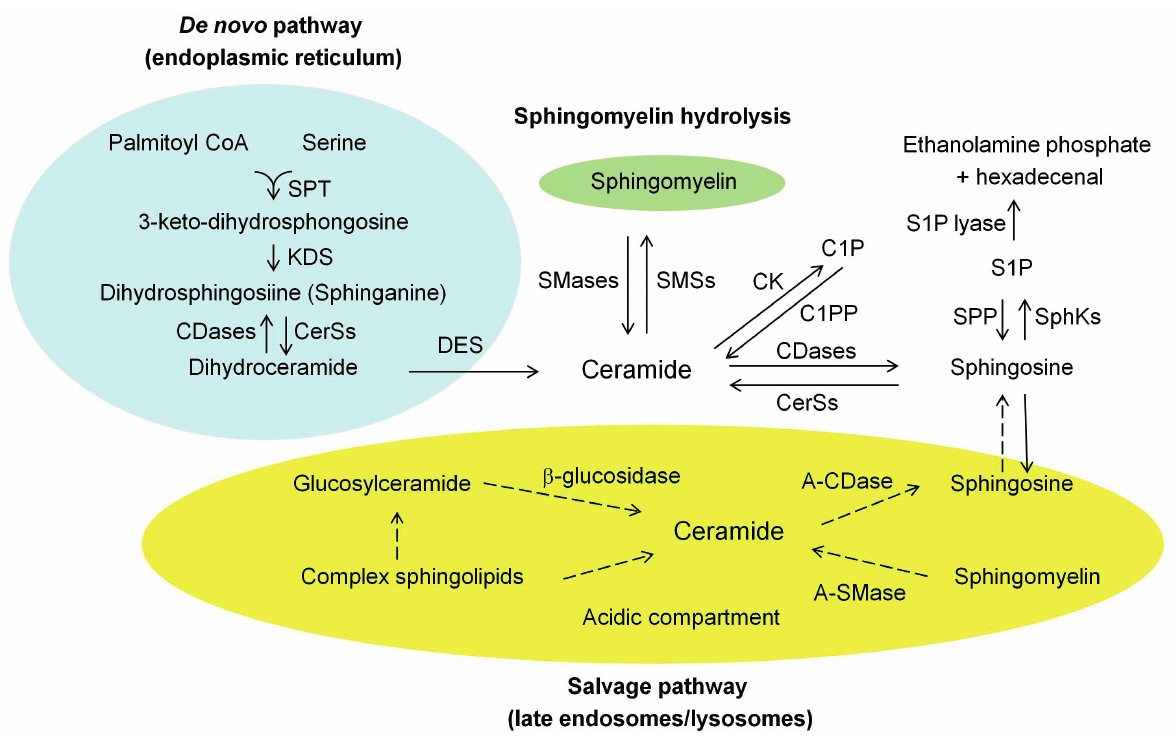
Figure 1. Metabolism of sphingolipids. Ceramide can be generated by three major pathways: (1) the de novo synthesis pathway, which occurs in the endoplasmic reticulum; (2) hydrolysis of sphingomyelin; and (3) the salvage pathway, which occurs in